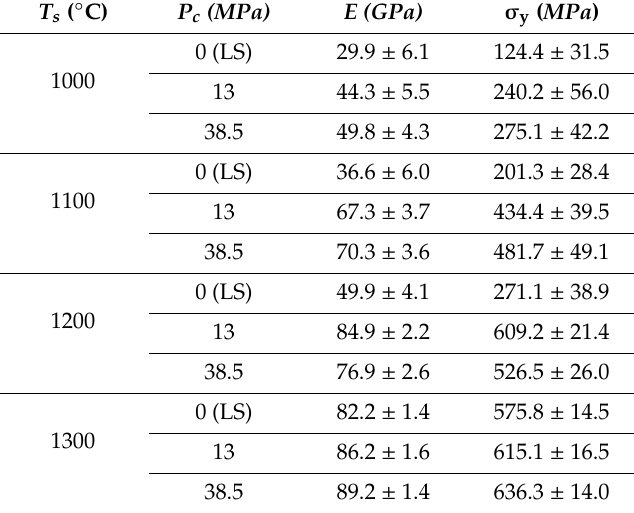
Table 3. Estimated values for elastic modulus and 0.2% offset yield strength by FE model.